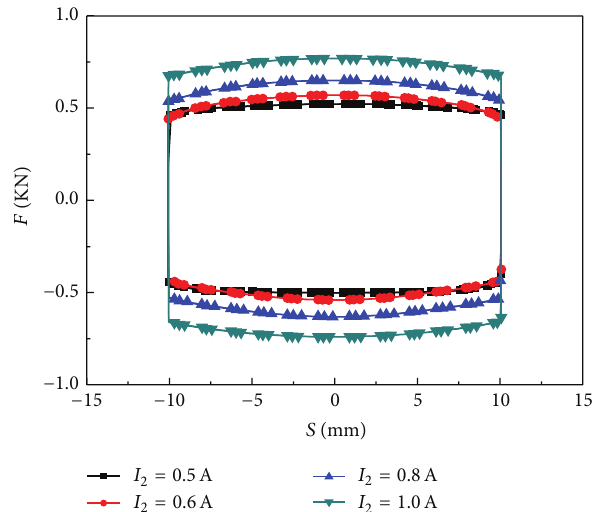
Figure 18: Comparison of simulated damping force and experimen- tal damping force at the applied current of 1.0 A.